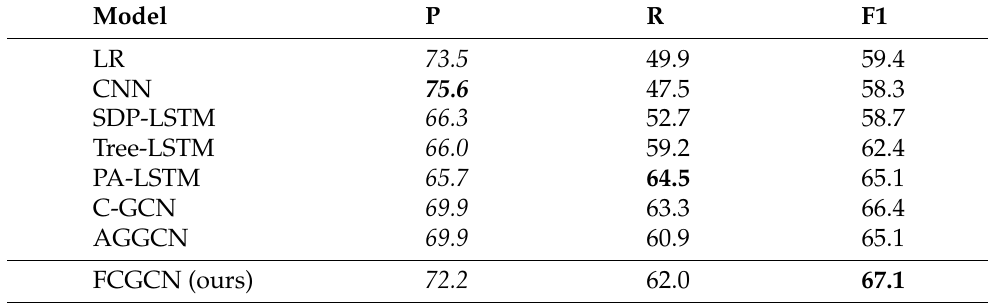
Table 2. Results on TACRED.